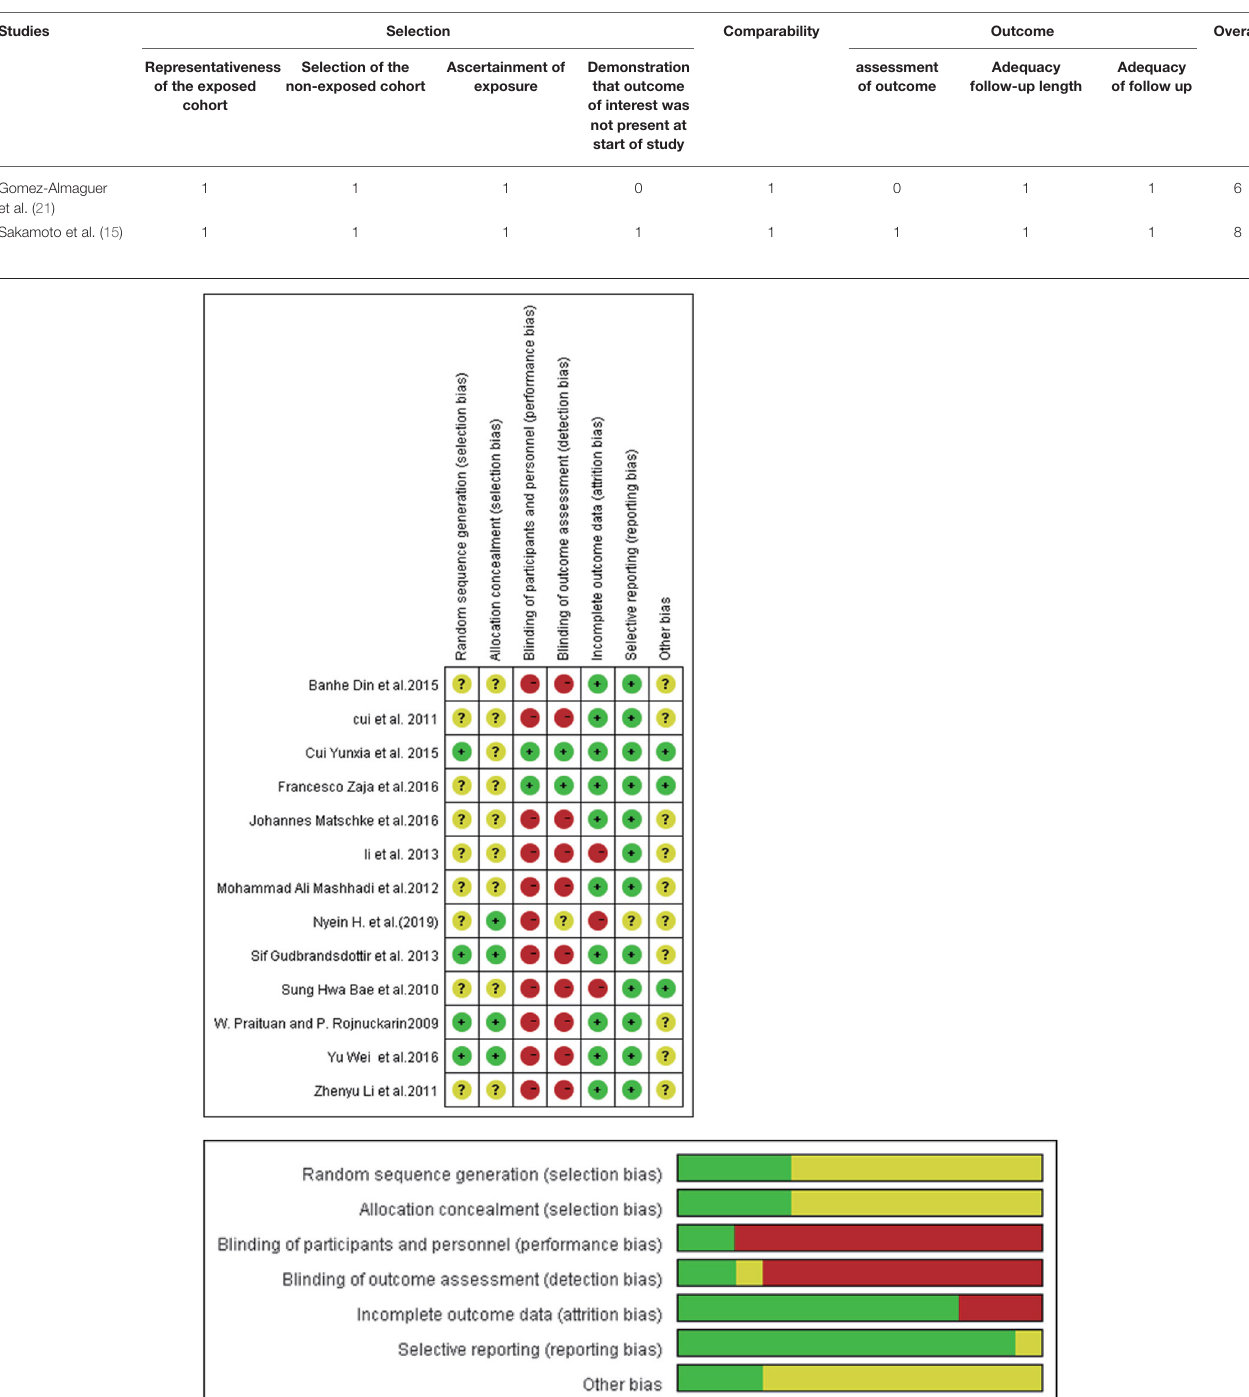
assessment Adequacy Adequacy of outcome follow-up length of follow up